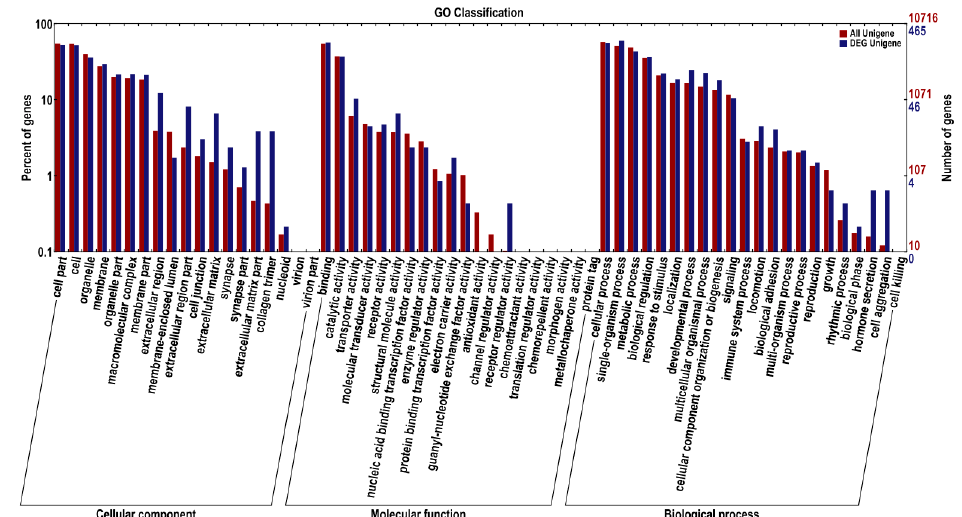
Figure 3. GO annotation of DEGs in the skin color of YL and GY of A. davidianus . The horizontal coordinate is the secondary node under three GO categories. The ordinate represents the number of genes annotated to this node and their percentage in the total number of genes. The red column represents the annotation of all genes, and the blue column represents the annotation of differentially expressed genes.